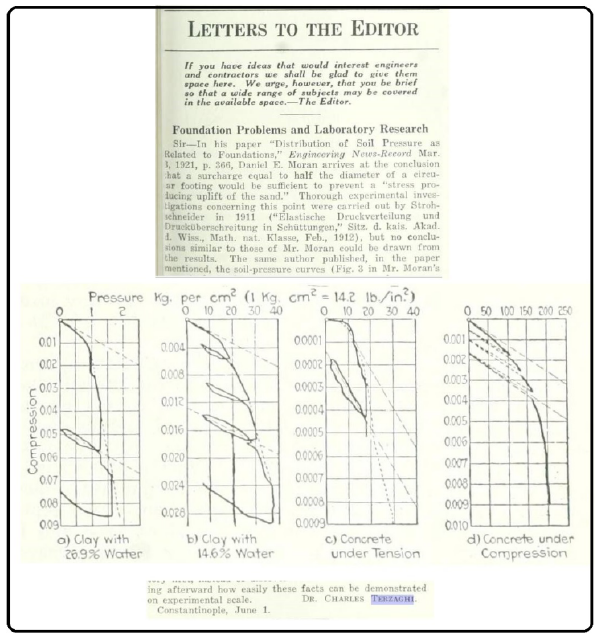
Figure 1. Karl Terzaghi’s paper in the Engineering News-Record journal (Terzaghi,